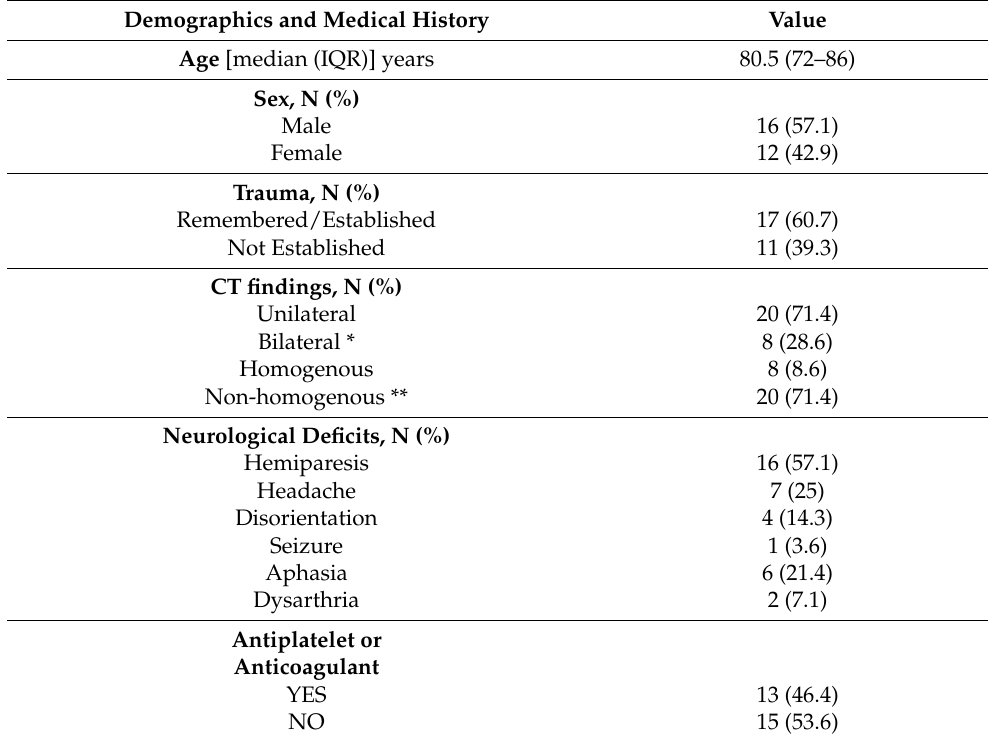
Table 1. Demographic profile, medical history and clinical findings of chronic subdural hematoma